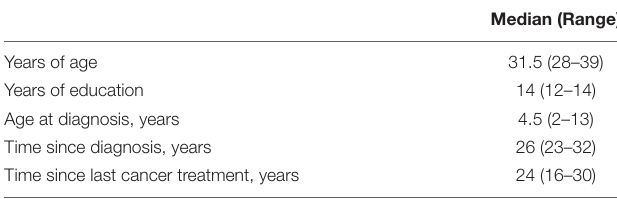
TABLE 1 | Demographic characteristics of the sample at baseline ( n = 4).